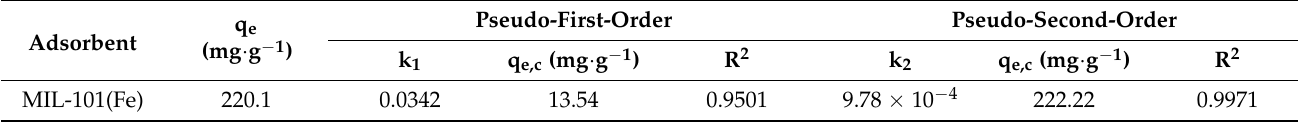
Figure 5. ( a ) Adsorption capacity of silicic acid as a function of time; ( b ) Linear fit using the pseu- do-first-order model; ( c ) Linear fit using the pseudo-second-order model. Table 1. Kinetic parameters of silicic acid adsorption process. Table 1. Kinetic parameters of silicic acid adsorption process.